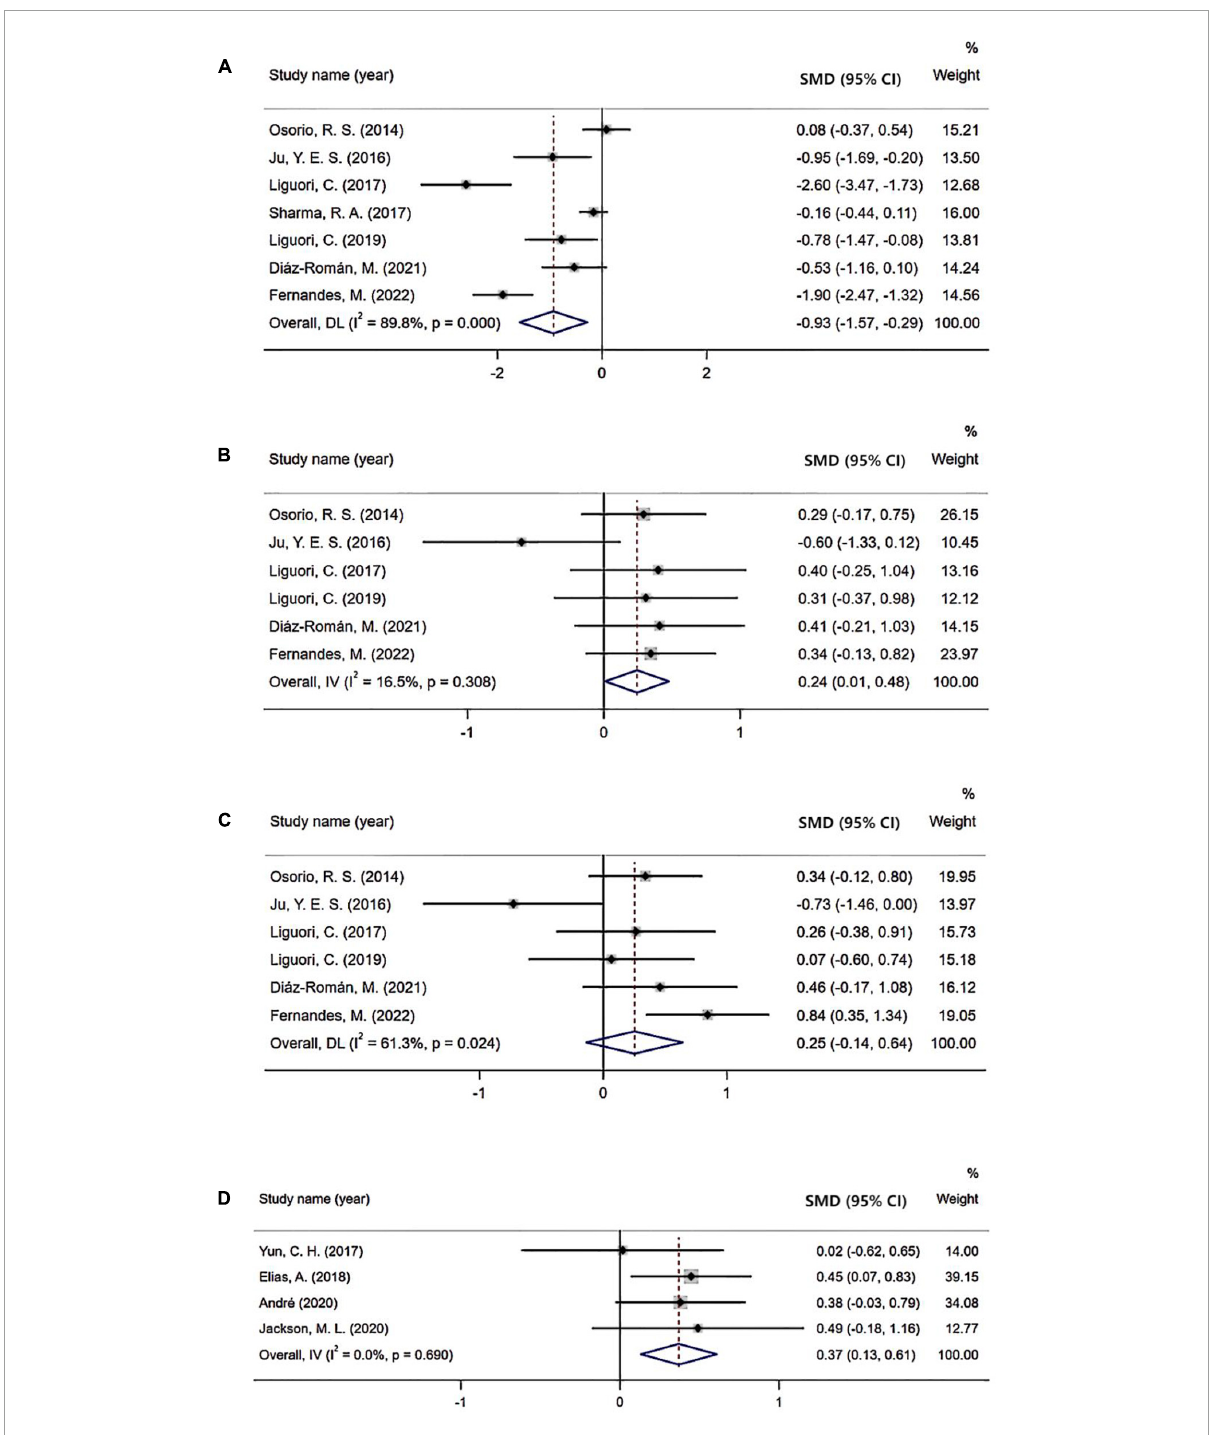
FIGURE2 Forest plot comparing levels of cerebrospinal fluid (CSF) and positron emission tomography (PET) biomarkers in subjects with obstructive sleep apnea (OSA) and controls: (A) CSF A β 42 level; (B) CSF t-tau level; (C) CSF p-tau level; (D) PET A β burden.